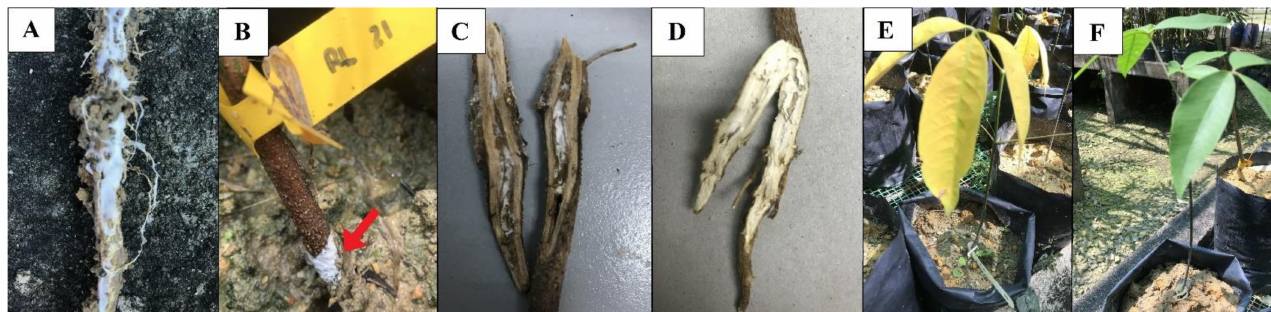
Figure 4. Signs and symptoms caused by R. microporus on rubber seedling: ( A ) full coverage of white rhizomorphs on the root surface at 1 MAI, ( B ) formation of white rhizomorphs on the collar region (arrow), ( C ) penetration of rhizomorphs to the root system, ( D ) healthy root from control seedling, ( E ) foliar symptom on rubber tree due to white root rot infection, and ( F ) healthy rubber tree with green leaves from control